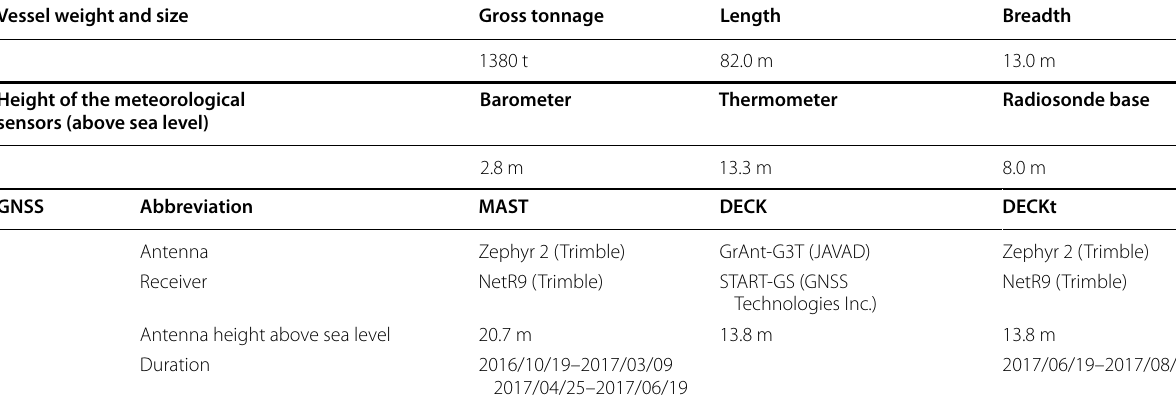
Table 1 Weights and sizes of the RYOFU MARU, the height of the meteorological sensors, and the specifications of the